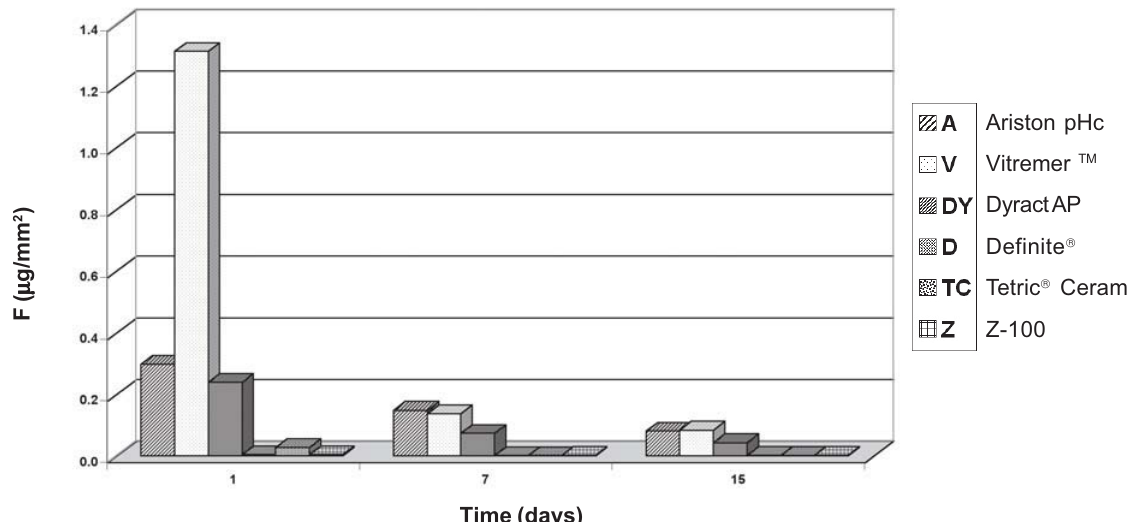
FIGURE 2- Fluoride release means (µg/mm 2 ) of the restorative materials in CpH during 24 hours at the 1 st , 7 th and 15 th days